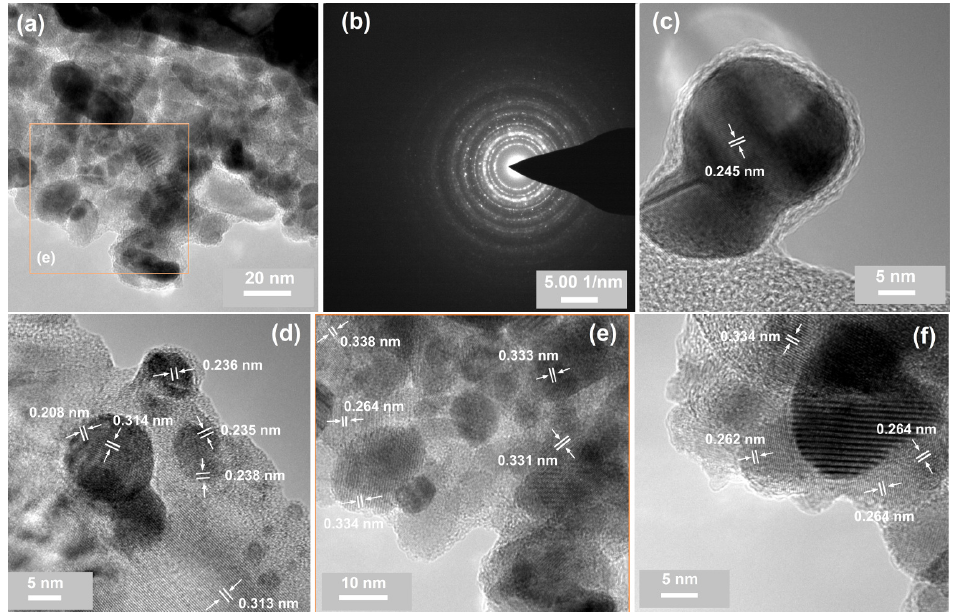
Figure 6. TEM characterization of the samples from the A and B series: ( a ) a TEM image at a lower magnification of a Sn/Au-rich material of sample B2*; ( b ) a selected-area electron diffraction (SAED) pattern of sample B2*; ( c ) a high-resolution TEM image presenting individual Au nanoparticles registered for sample A2*; ( d ) a high-resolution TEM image illustrating a Au/Si-rich area of sample A2; ( e ) a high-resolution TEM image of a selected area of ( a ); ( f ) a high-resolution TEM image of a bimetallic fragment of sample B2*; Moiré fringes are visible.